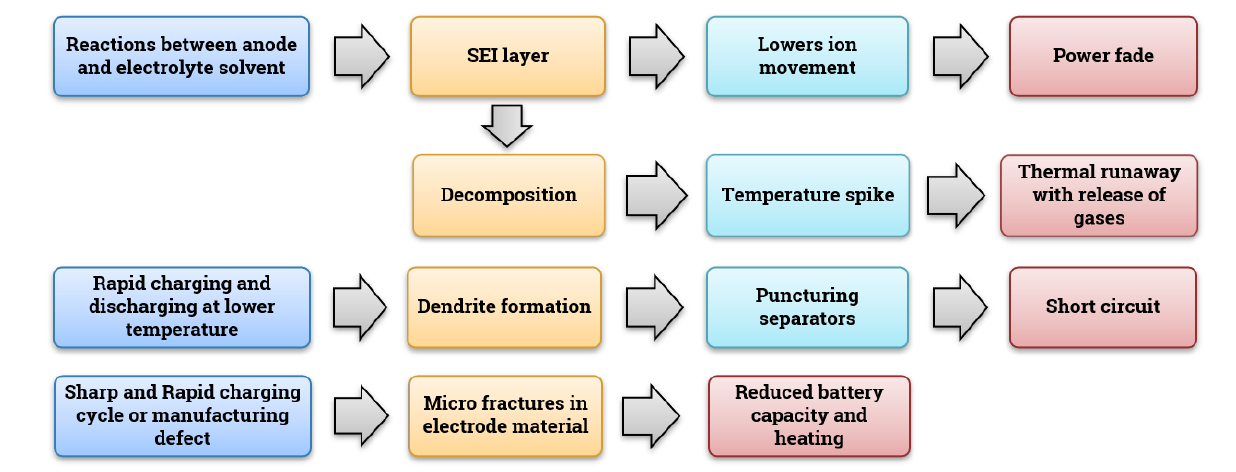
Figure 4. Anode active material failure mechanism.